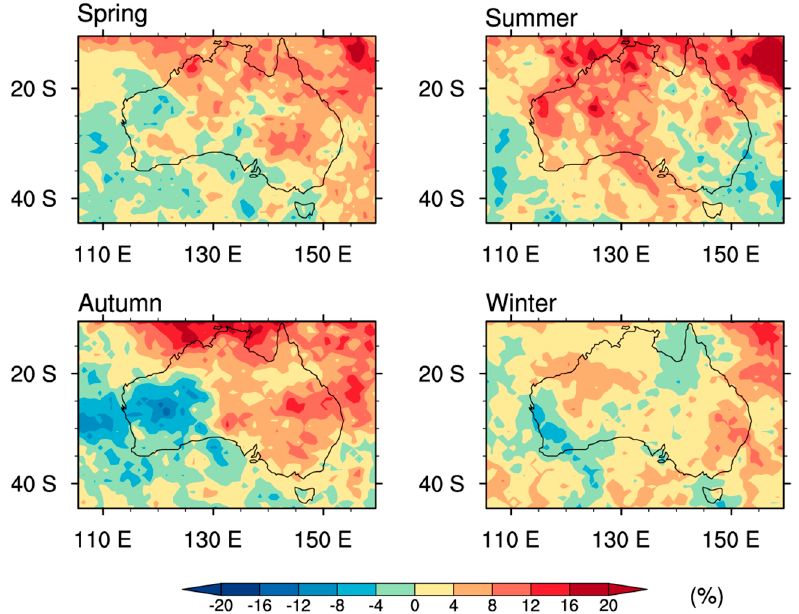
Figure 4. The difference in HIRS high thick (CTP < 440 hPa; 0.5 < ε < 0.95) cloud observation percentages between La Niña seasons and El Niño seasons selected during the period 1985 to 2001 for the Australian region (10 ◦ S–45 ◦ S, 105 ◦ E–160 ◦ E). Data summarised from four El Niño seasons (August 1986–February 1988, April 1991–July 1992, August 1994–April 1995 and April 1997–April 1998). Data summarised from two La Niña seasons (May 1988–June 1989 and June 1998–April 2001). Difference = La Niña–El Niño. Images separated into Southern Hemisphere spring months ( top left ), summer months ( top right ), autumn months ( bottom left ) and winter months ( bottom right ) from El Niño and La Niña